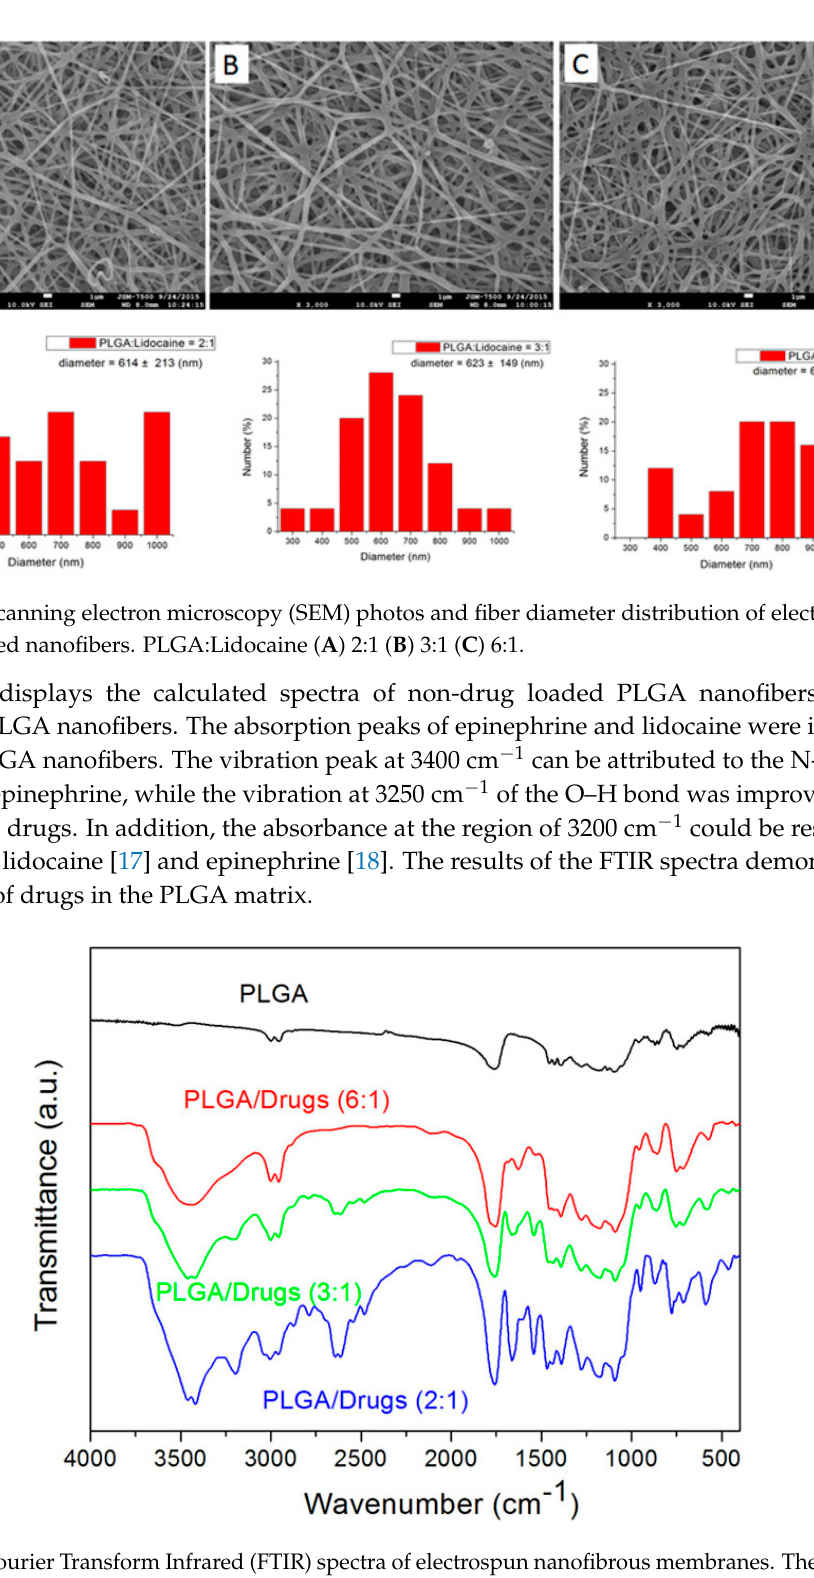
Figure 3. Fourier Transform Infrared (FTIR) spectra of electrospun nanofibrous membranes. The results of the FTIR spectra demonstrated the incorporation of drugs in the poly[( D , L )-lactide- co -glyco lide] (PLGA) matrix.